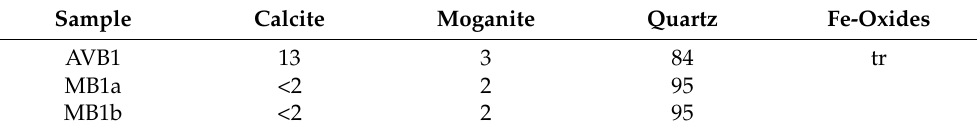
Table 2. Semi quantitative analysis of mineral composition in studied samples (% crystalline phases).